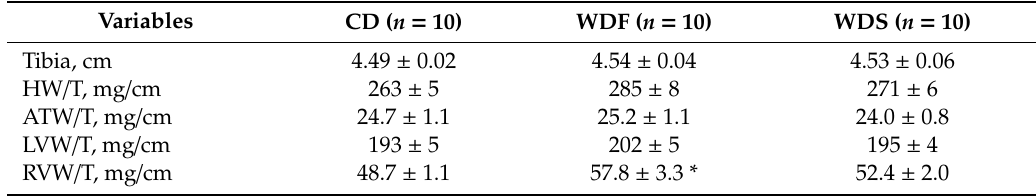
Table 3. Macroscopic cardiac remodeling.